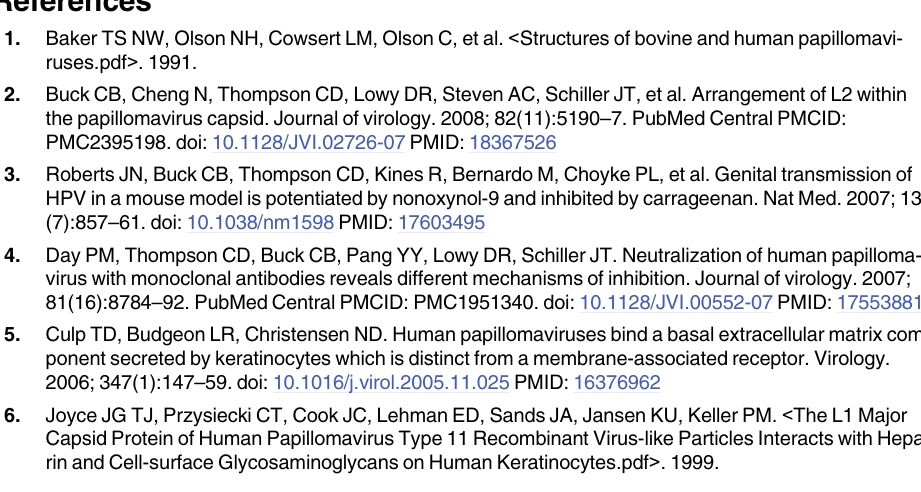
S4 Fig. Cell cycle profiles of DCT knockdown and XXI treated cells with their correspond- ing control treatments. S1 Table. Cell count results of DCT and control siRNA treated HaCaTs.